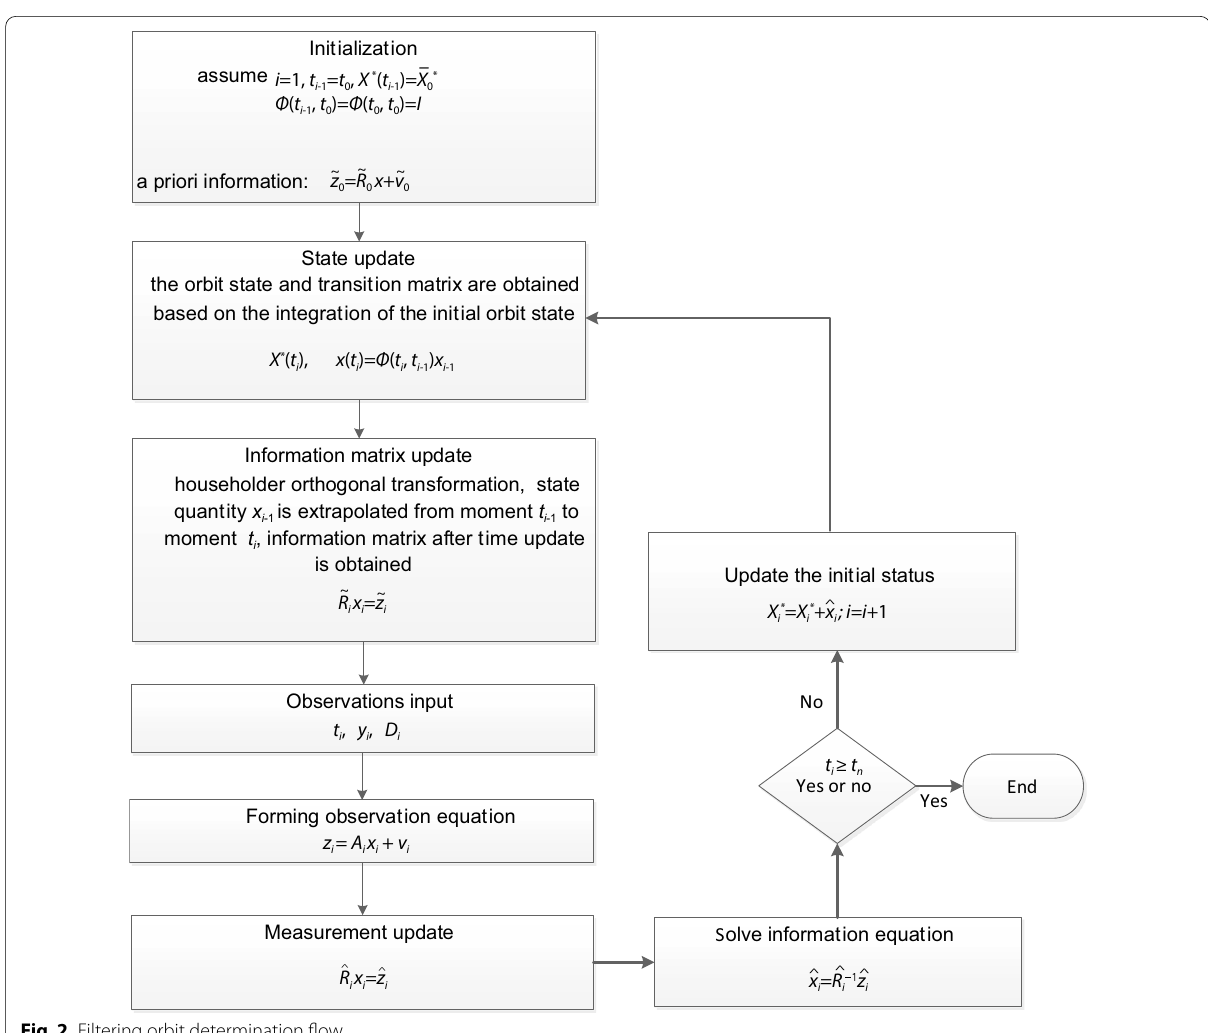
Fig. 2 Filtering orbit determination flow